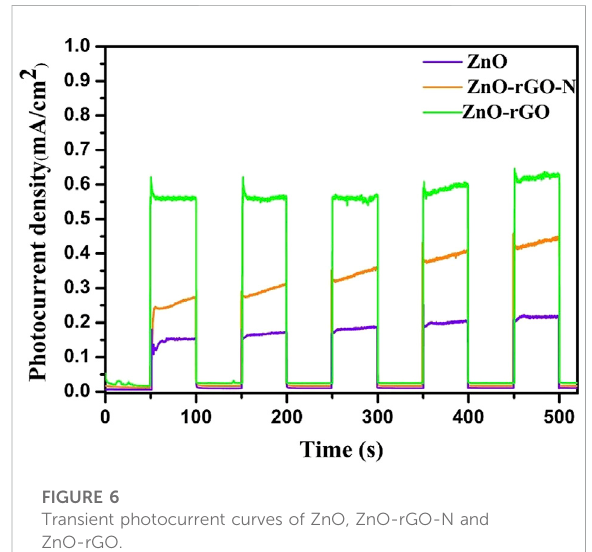
FIGURE 6 Transient photocurrent curves of ZnO, ZnO-rGO-N and